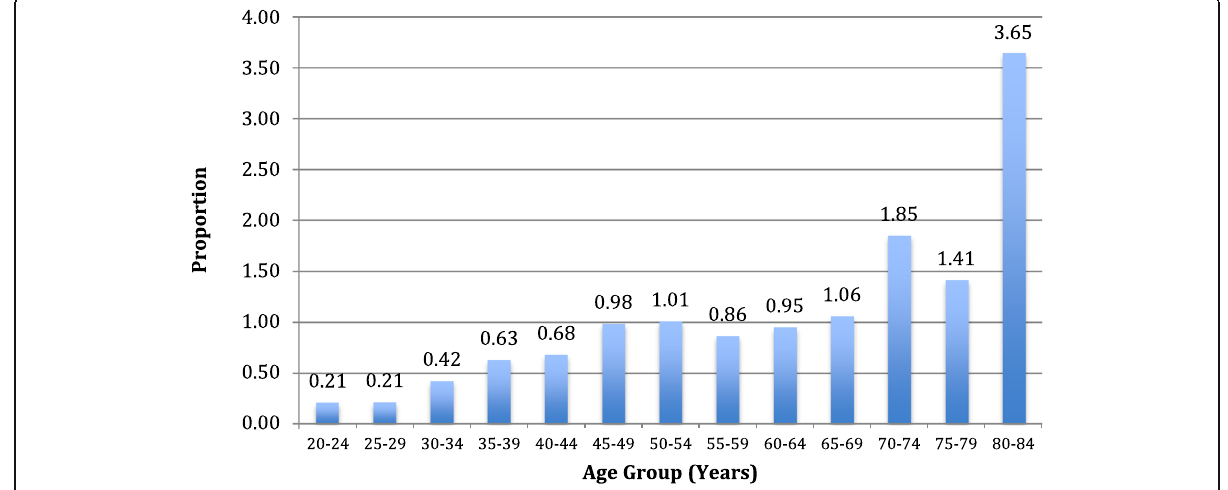
Fig. 2 Proportion of men ≥ 18 years presenting with hydrocoele by